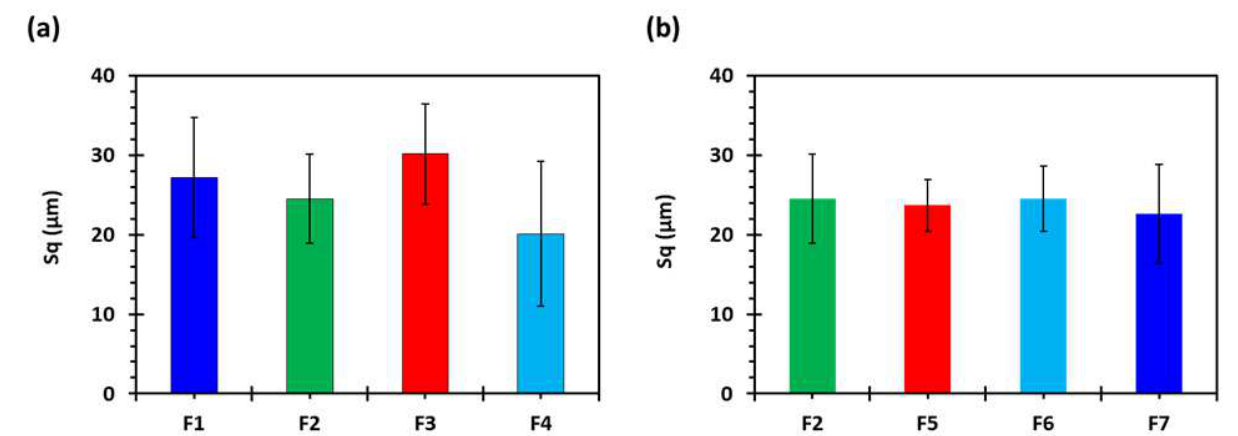
Figure 8. Surface roughness properties of 3D-printed tablets, showing the effect of ( a ) shell number and ( b ) infill percentage (n = 5). F1 (1 shell with 0% infill); F2 (2 shells with 0% infill); F3 (3 shells with 0% infill); F4 (4 shells with 0% infill); F5 (2 shells with 10% infill); F6 (2 shells with 20% infill); and F7 (2 shells with 30% infill).